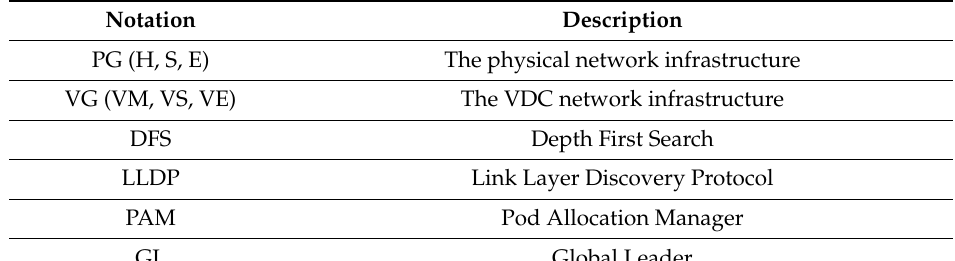
Table 1. Notations description.